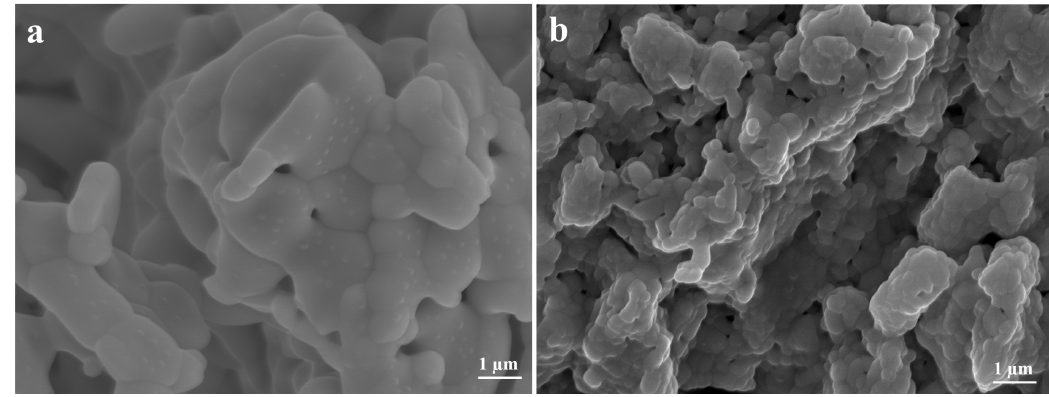
Figure 4. Post ‐ oxidation SEM images of ( a ) pure TaC and ( b ) pure HfC. Figure 4. Post-oxidation SEM images of ( a ) pure TaC and ( b ) pure